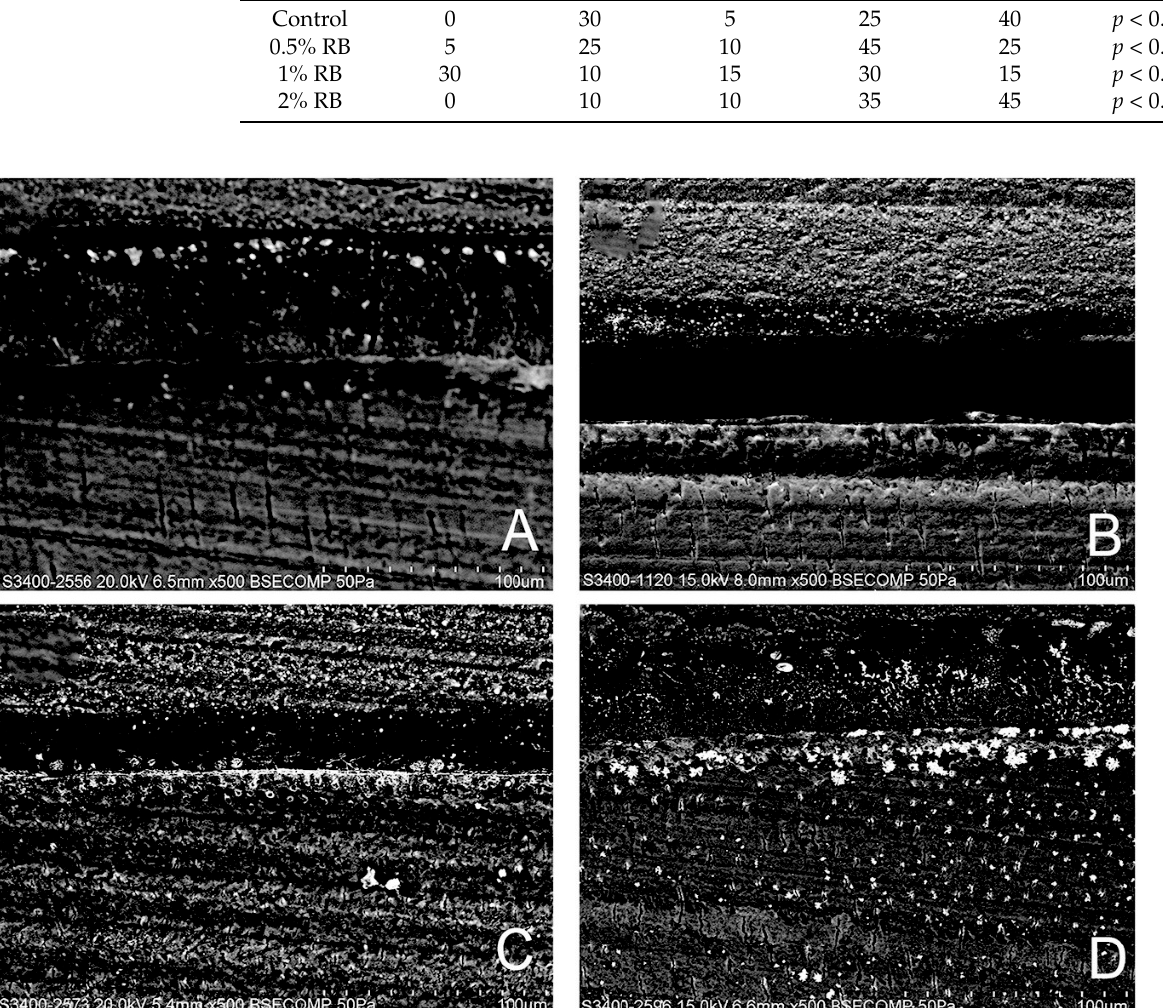
Figure 5. The distribution of nanoleakage scores of different groups is depicted in SEM